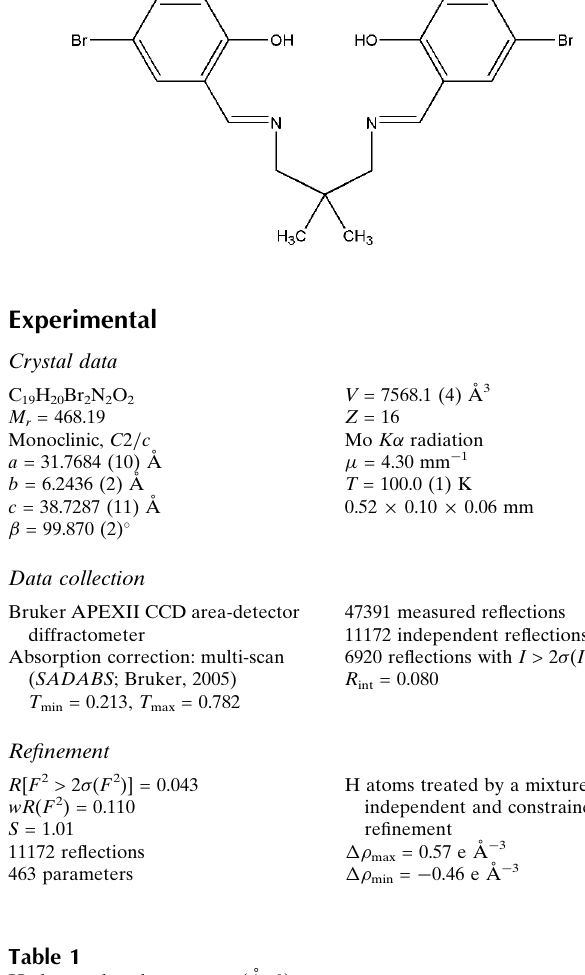
Hydrogen-bond geometry (A˚ , (cid:3) ). D —H (cid:1)(cid:1)(cid:1)